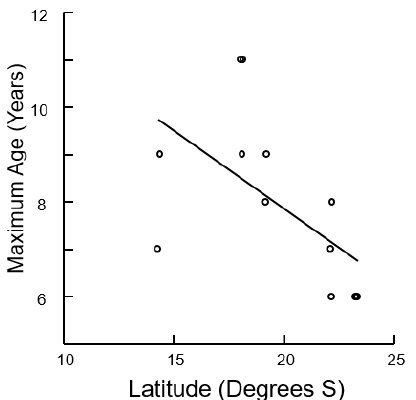
Figure 4. The relationship between age max (AMAX) and latitude for A. polyacanthus from 13 outer reefs only. Collections from all reefs are included in this analysis with a minimum of 66 fish (range 66–155) collected at any one reef ( n = 13 reefs). R 2 = 0.34, ANOVA for slopes, F 1,11 = 5.74; p < 0.03.